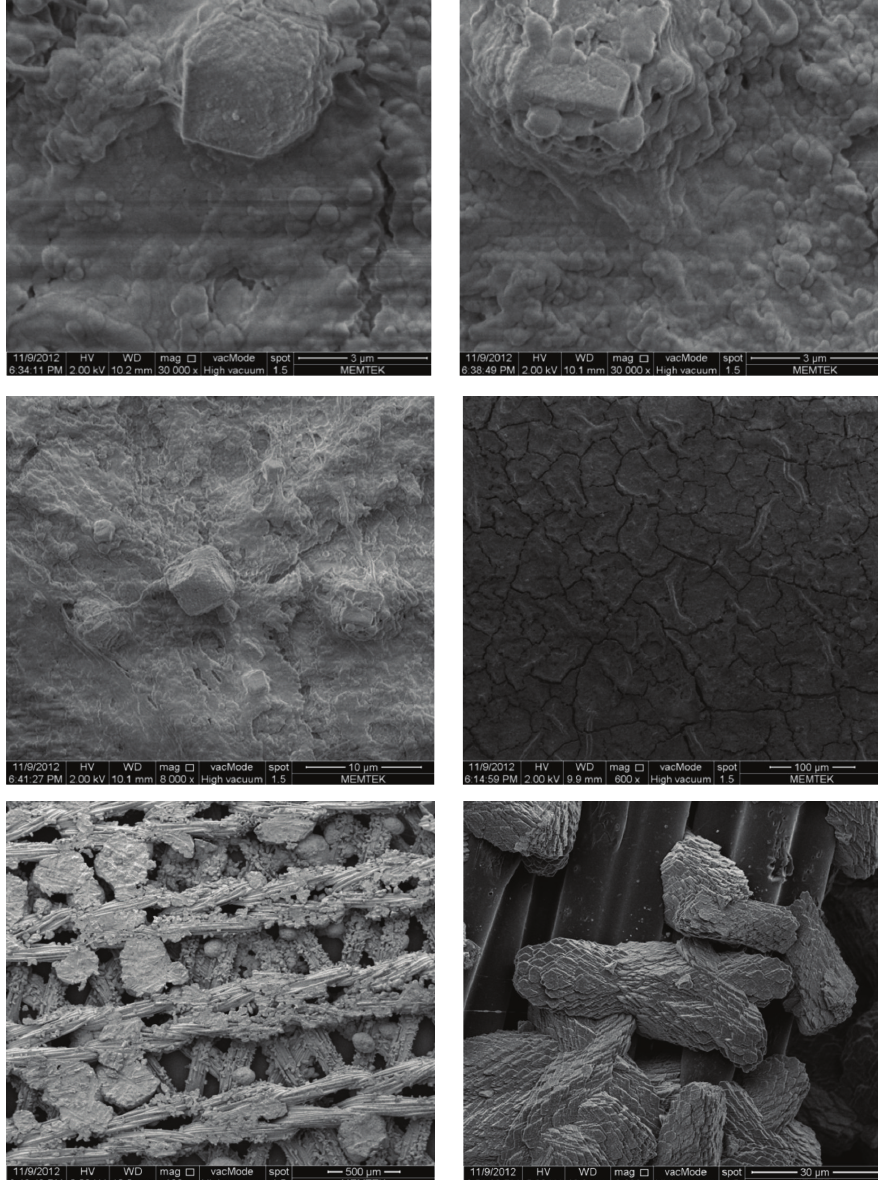
Figure 4: SEM analysis of membranes and